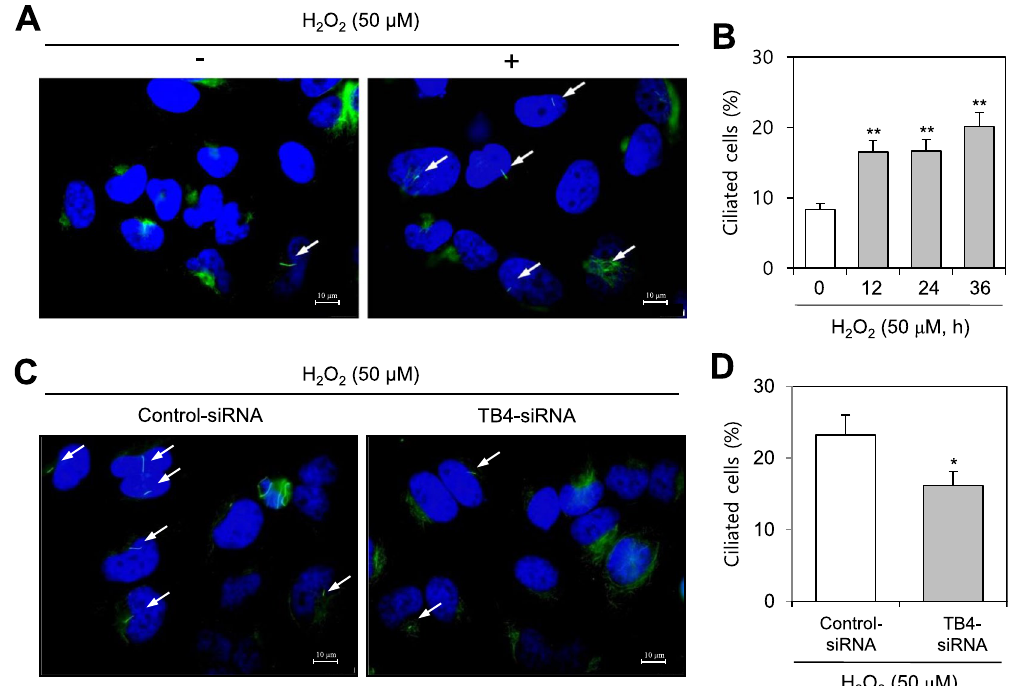
Figure 3. H 2 O 2 increased primary cilium formation in HeLa cells. ( A – D ) HeLa cells were incubated with 50 μM H 2 O 2 for up to 36 h ( A , B ). Cells were transfected with AccuTarget negative control-siRNA or TB4- siRNA for 24 h. Then, cells were incubated with 50 μM H 2 O 2 ( C , D ). The cells were fixed and stained with antibody against Ac-tubulin. The representative image of primary cilia was observed with 400X magnification under fluorescence microscope. White arrows indicated primary cilia ( A , C ). The ciliated cells out of more than 1,000 cells in the absence (white) or presence (grey) of H 2 O 2 were counted. PC frequency was evaluated by the blinded double scoring ( B , D ). Each result was the representative of experiments performed at least four times and each experiment was performed with four samples (n = 4) in the same group. Data in bar graphs represents the means ± SD. * p < 0.05, ** p < 0.01; significantly different from H 2 O 2 -untreated control cells ( B ) or control- siRNA-treated and H 2 O 2 -treated control cells ( D